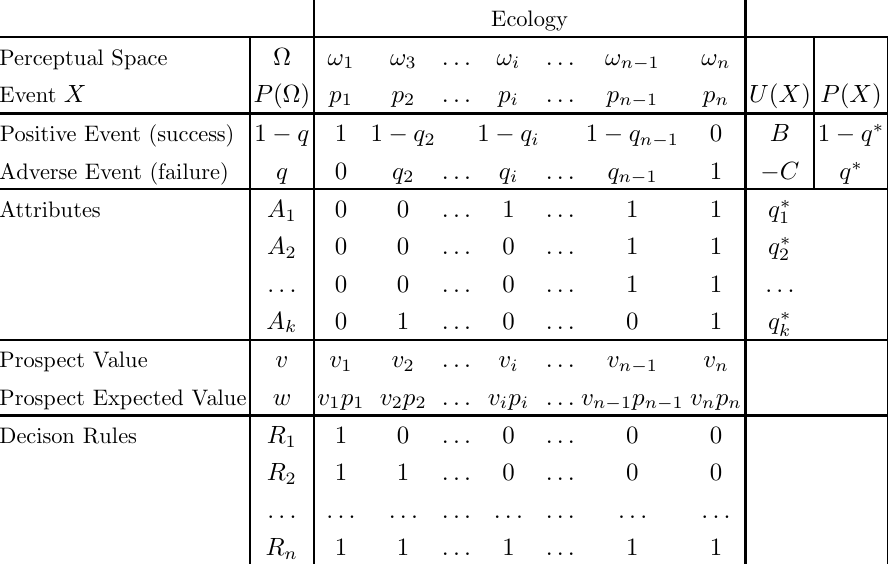
Formal parameters of the model of cognitive adaptation to ecology Perceptual